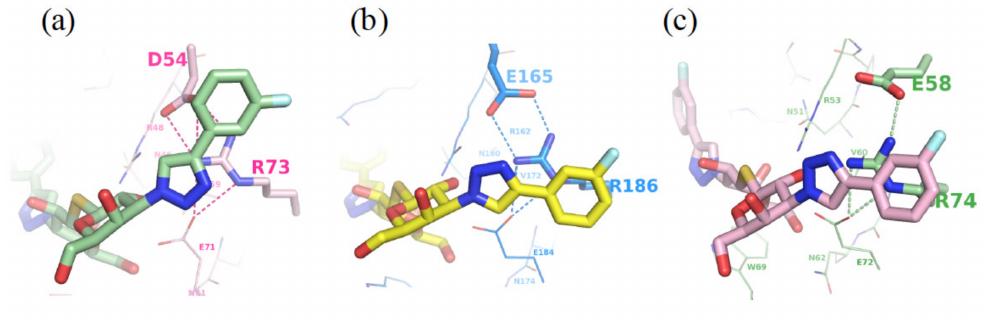
Figure 5. Structures of ( a ) GAL-1 (PDB code: 4Y24), ( b ) GAL-3 (5H9P), ( c ) GAL-7 (5H9Q) in complex with TD139 to display the ion-pair- π ( a ) or tandem arginine- π ( b , c ) interactions at subsite E. The salt bridges between Asp/Glu and Arg (in dotted lines) are essential for controlling the orientation of Asp and Arg involved in the aforementioned